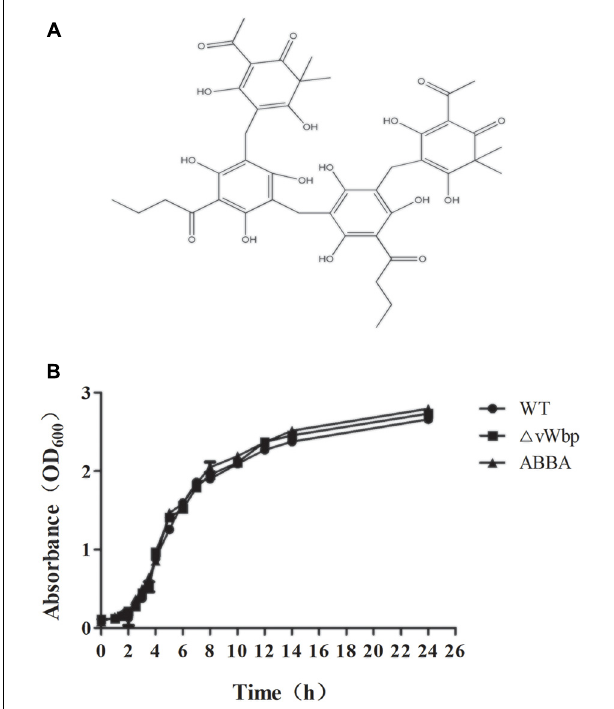
FIGURE 3 | Western blot analysis of vWbp expression levels. (A) Western blotting was performed to detect the expression levels of vWbp incubated with 16, 32, 64, 128 or 256 µ g/ml ABBA and (cid:49) vWbp. (B) Analysis of gray levels of the protein